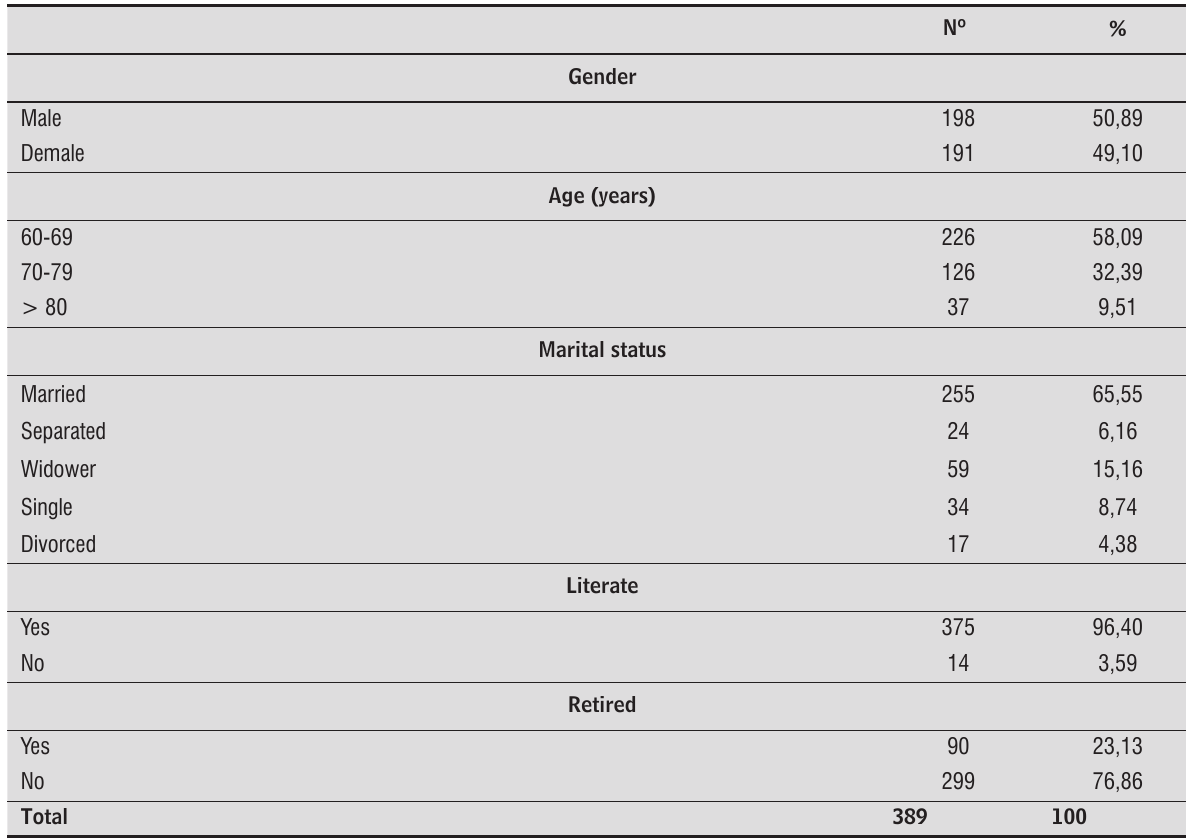
Table 5 quantifies the number of falls per year